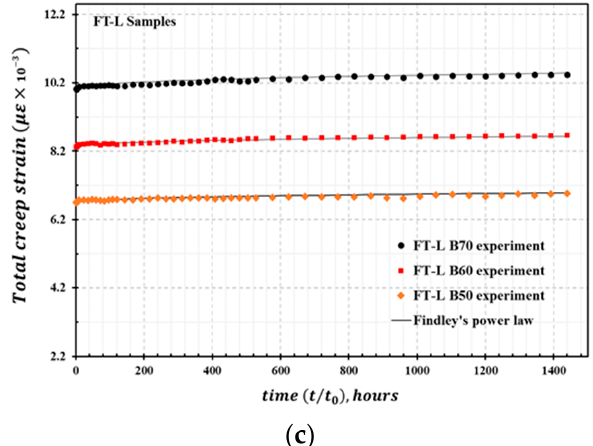
Figure 10. Total creep strain curve derived from theoretical prediction compared with experimental strain: ( a ) RT samples, ( b ) FT samples, and ( c ) FT-L samples.